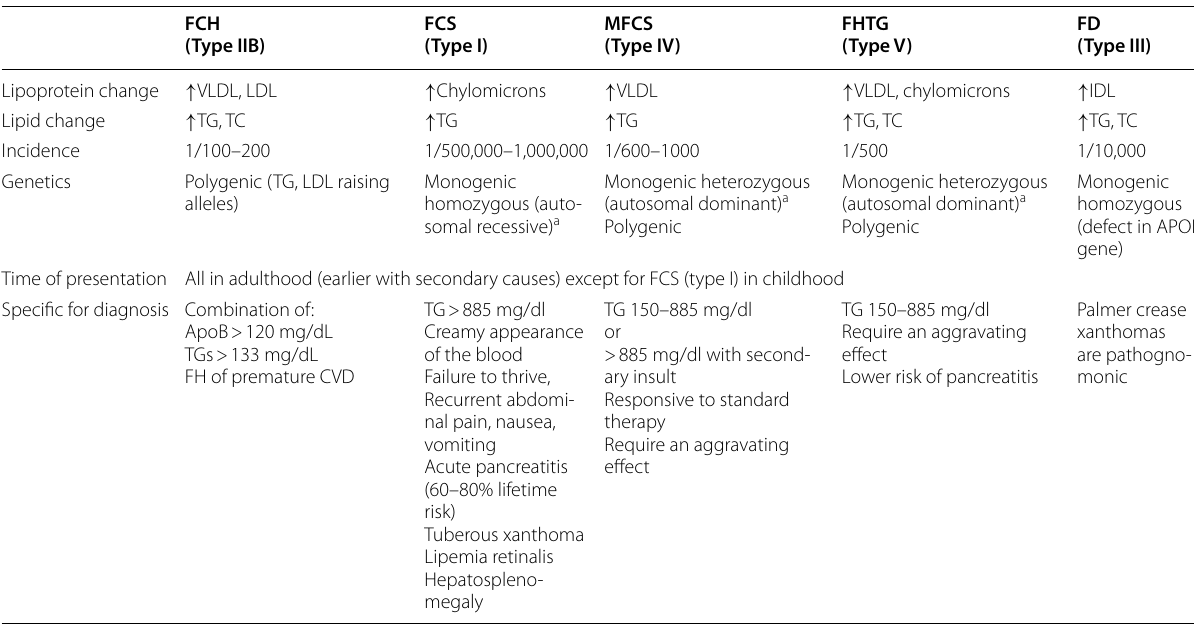
Table 3 Different types of familial HTG [19–22]